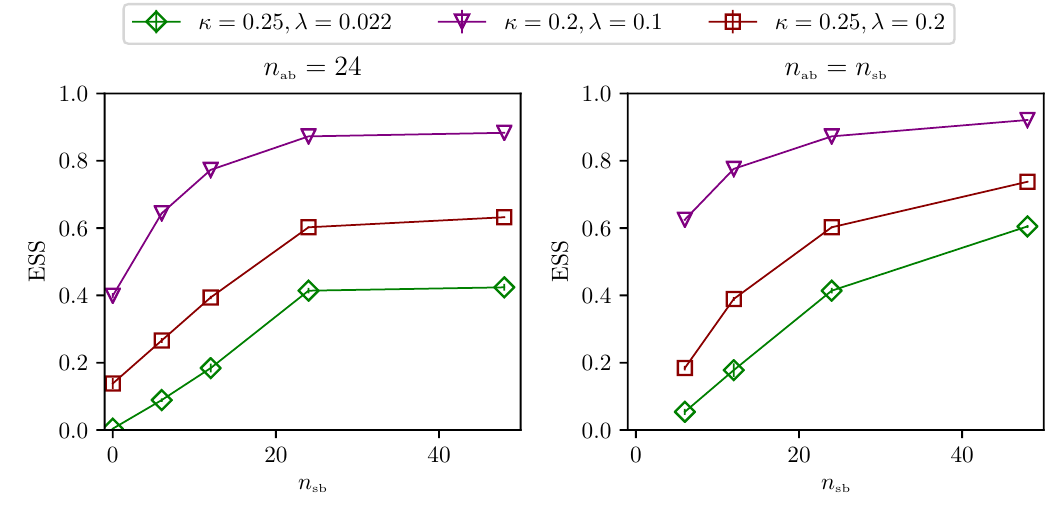
Figure 9 . ESS comparison for 16 × 8 lattices between CNN-based SNFs with n sb = 24 (left panel) and n sb = n ab (right panel), for different values of the target